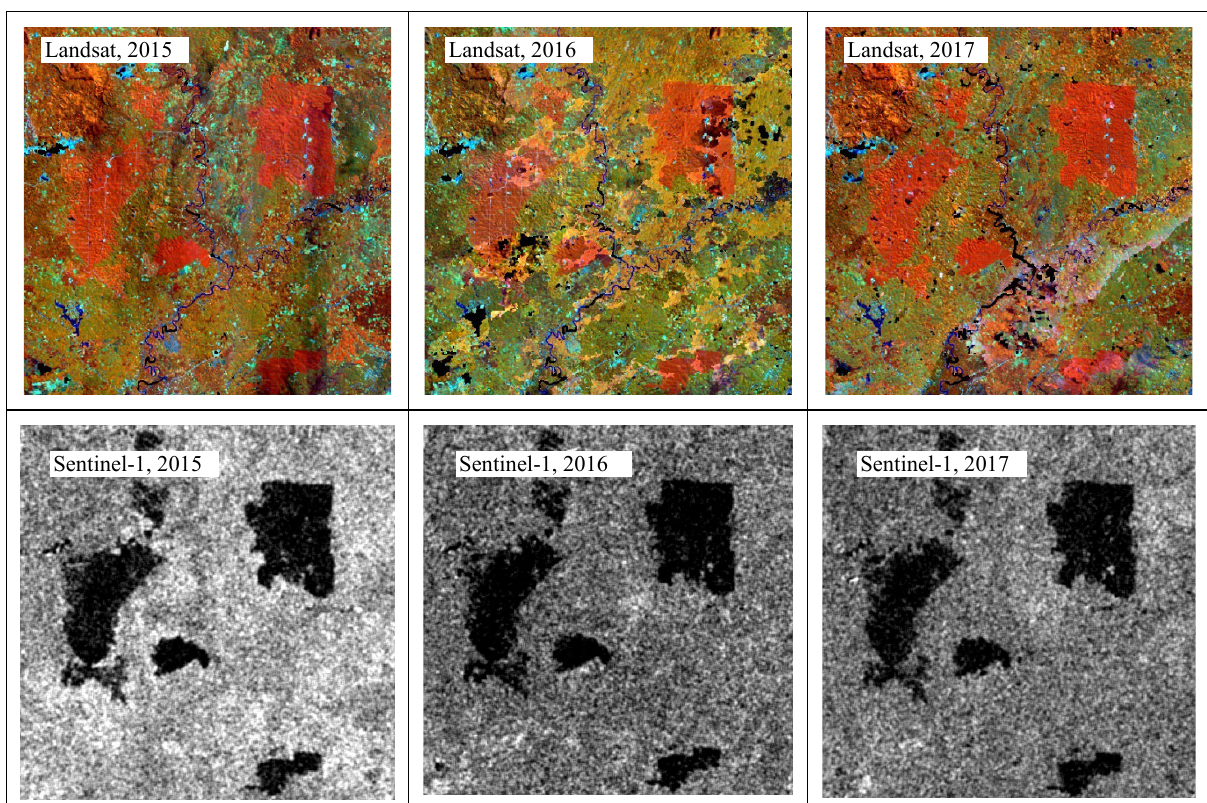
Figure 2. Mosaic images of Landsat-8 and Sentinel-1 from 2015–2017.